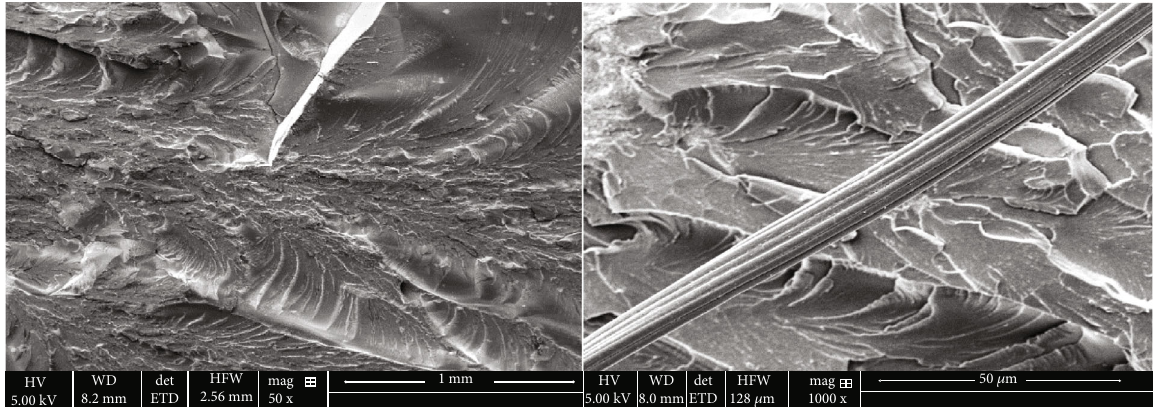
Figure 15: Fracture surfaces due to tensile failure in a 0.5wt.% MWCNT-reinforced epoxy composite subjected to 1500 thermal cycles.